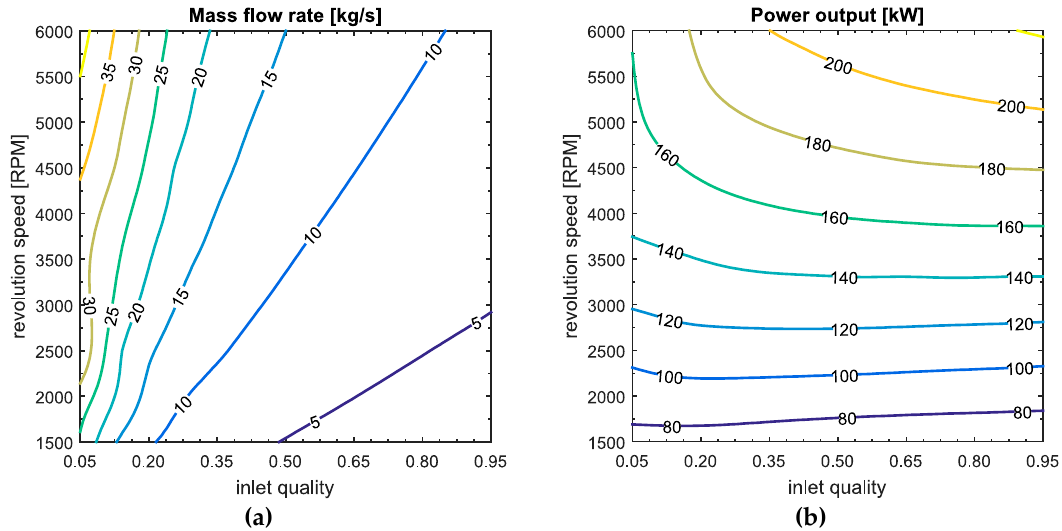
Figure 9. Twin-screw expander performance maps at constant manometric pressure ratio (Table 2): effects on the mass flow rate ( a ) and mechanical power output ( b ).